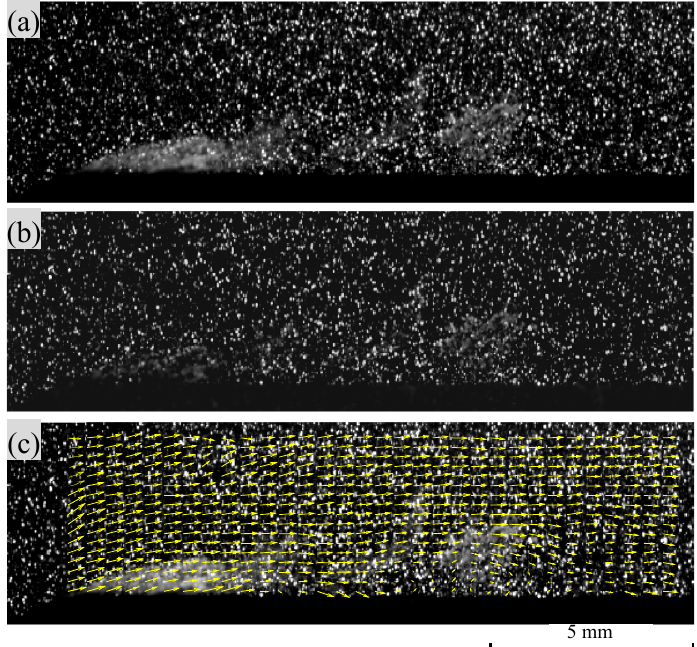
Figure 6. An example of evaluating an instantaneous velocity field in the cavitating flow ( σ = 2.49, (cid:1873) (cid:3036)(cid:3041) = 8.75 m/s): ( a ) raw PIV image, ( b ) processed image with a high-pass Gaussian filter and ( c ) instantaneous velocity vector field (every second vector is displayed in the horizontal direction for clarity).